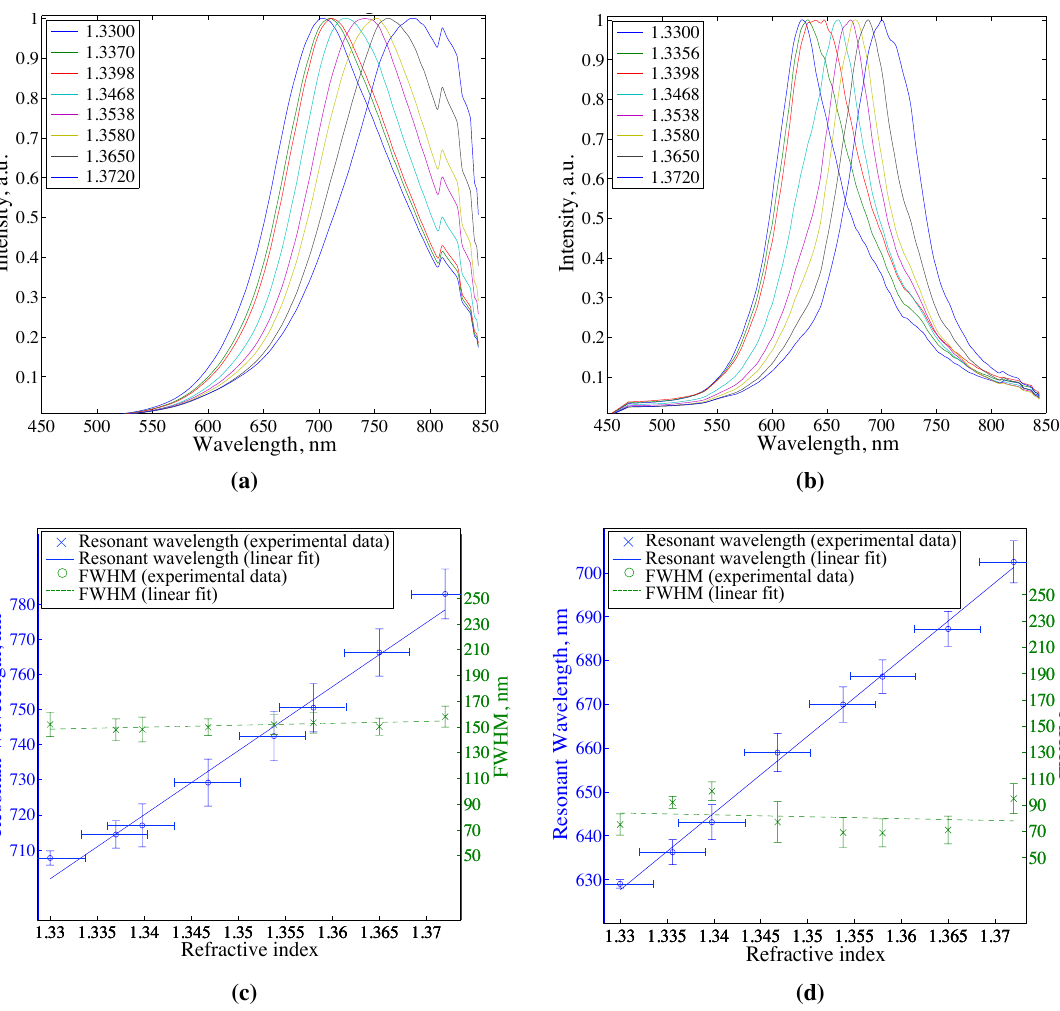
Figure 3. Normalized scattered spectra for ( a ) bare core fiber SPR sensor and ( b ) exposed Figure 3. Scattered spectra for (a) bare core fiber SPR sensor and (b) exposed core fibre (ECF) SPR sensor. Legends show the values of glycerol solutions’ RIs used in the core fibre (ECF) SPR sensor. Legends show the values of glycerol solutions’ refractive experiment. Sensitivity curves and FWHM for (c) bare core SPR sensor and (d) ECF SPR indices used in the experiment. Sensitivity curves and full width at half maximum ( FWHM ) sensor. Bare core sensor: core diameter 140 µm , silver film thickness 57 nm . ECF sensor: for ( c ) bare core SPR sensor and ( d ) ECF SPR sensor. Bare core sensor: core diameter core diameter 10 µm , silver film thickness 55 nm . 140 µ m, silver film thickness 57 nm. ECF sensor: core diameter 10 µ m, silver film thickness 55